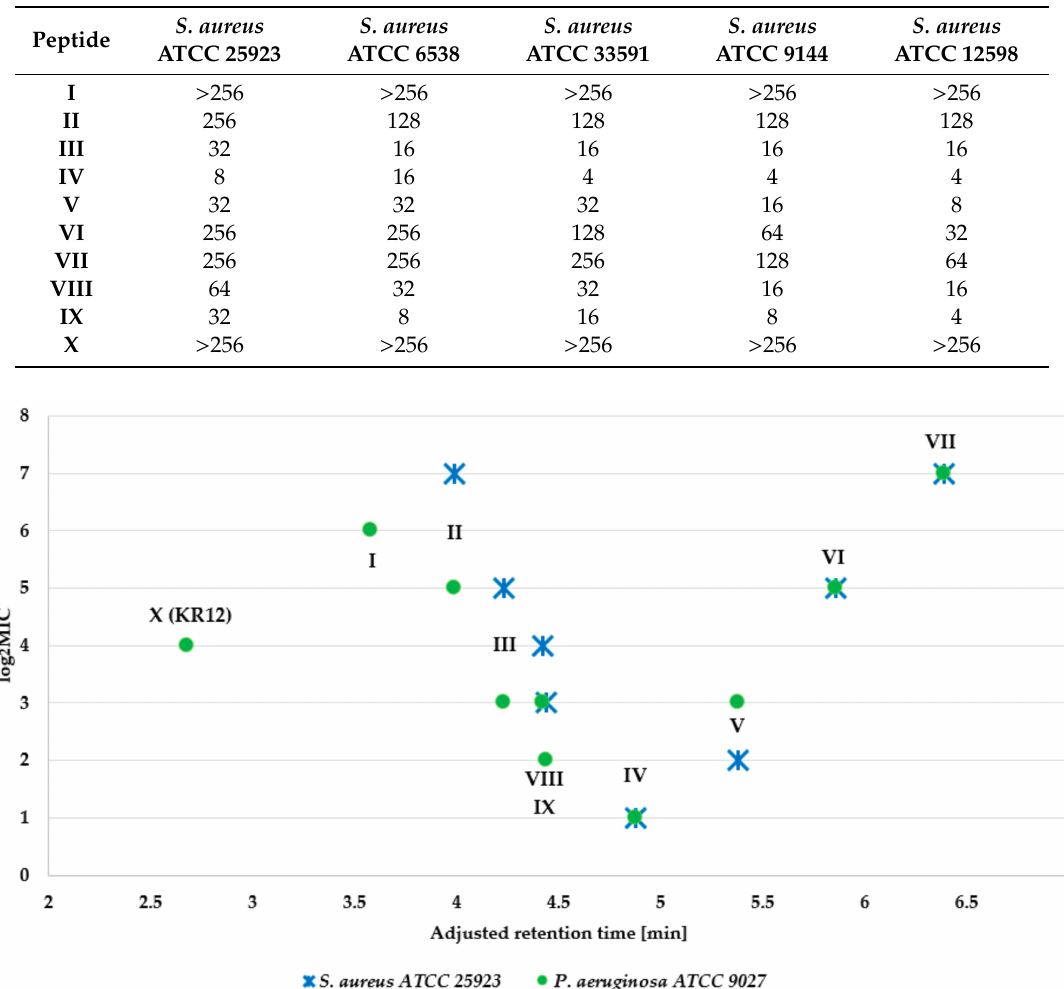
Table 4. The MBEC values ( µ g / mL) of the test peptides against reference strains of S. aureus.